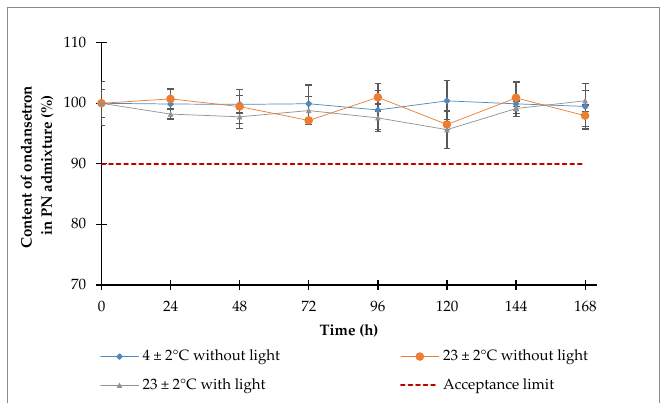
Figure 4. Content (%) of OND during seven days of storage.